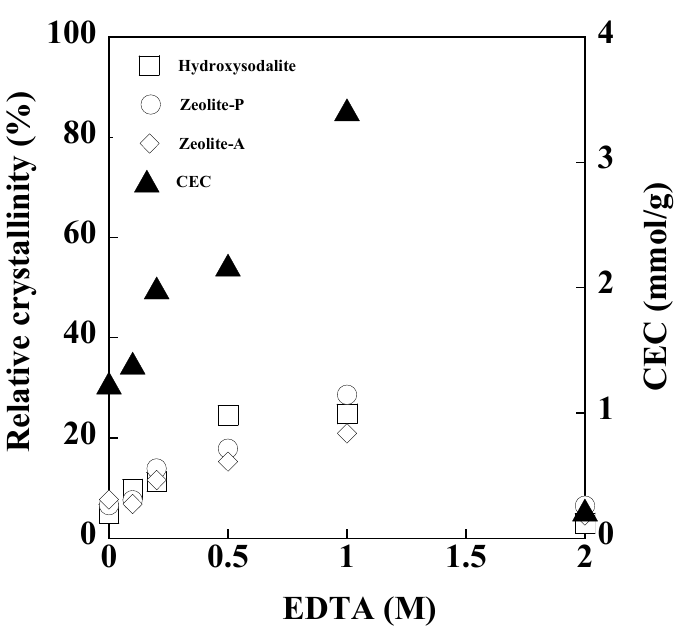
Figure 3. Relative crystalinities of hydroxysodalite, zeolite-P, and zeolite-A in the product, and CECs of the product after synthesis with various concentrations of added EDTA (NaOH concentration: 3 M NaOH, Temperature: 80 °C, Reaction time: 24 h).